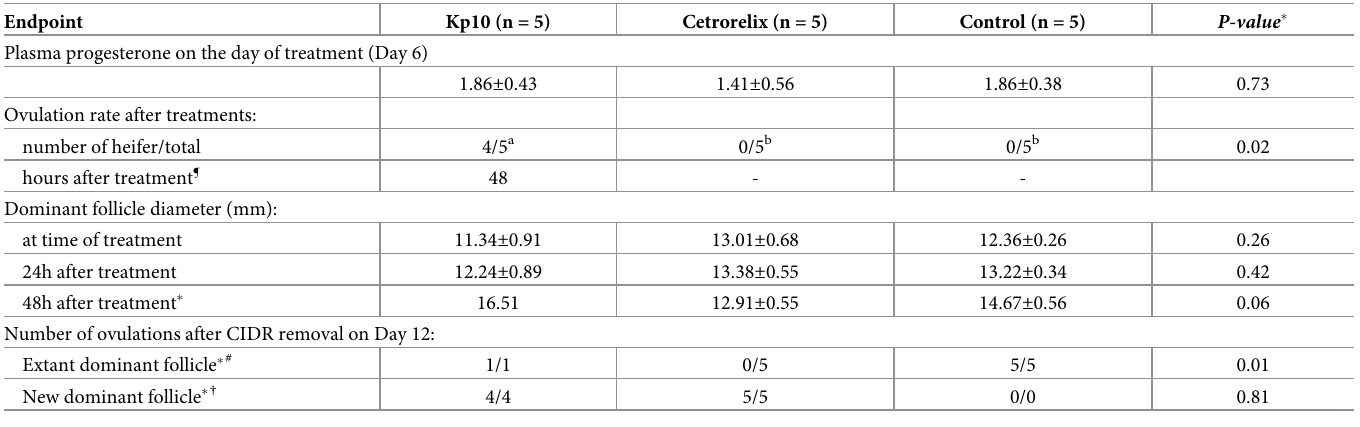
Table 3. Ovarian and endocrine responses (mean ± SEM) of heifers treated with human Kisspeptin-10 (Kp10 group), pre-treatment with cetrorelix before Kisspep- tin-10 (Cetrorelix group) or normal saline (Control group) intravenously under subluteal levels of plasma progesterone in Experiment